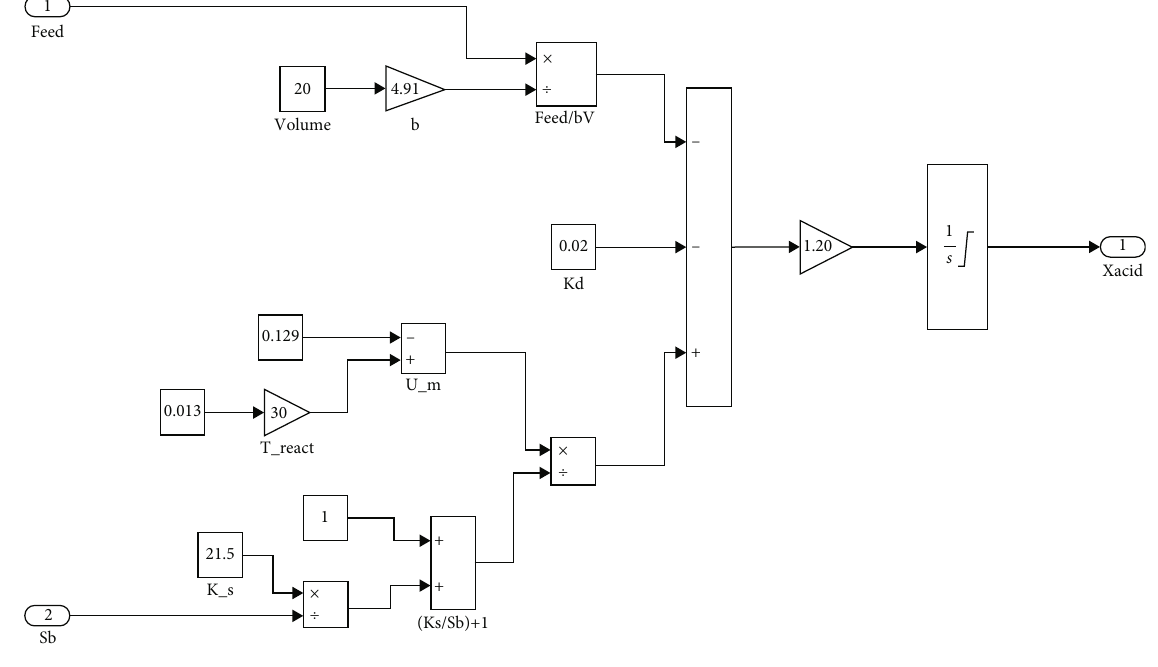
Figure 5: Simulink model of acetogenesis.